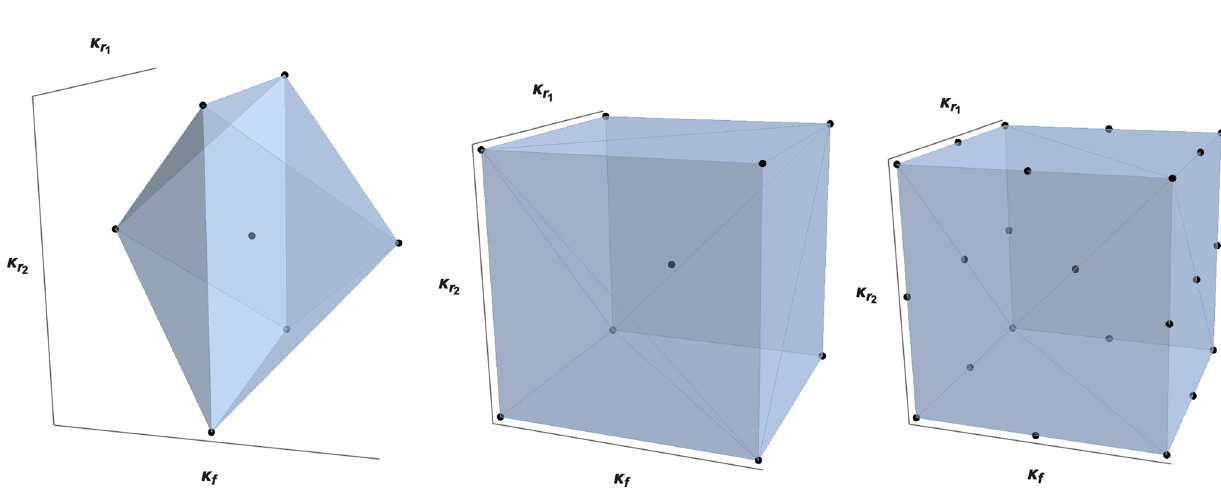
Fig. 3 Same as Fig. 2, now for the case of two different processes π 1 and π 2 with a common factorization scale κ f and different renormal- ization scales κ